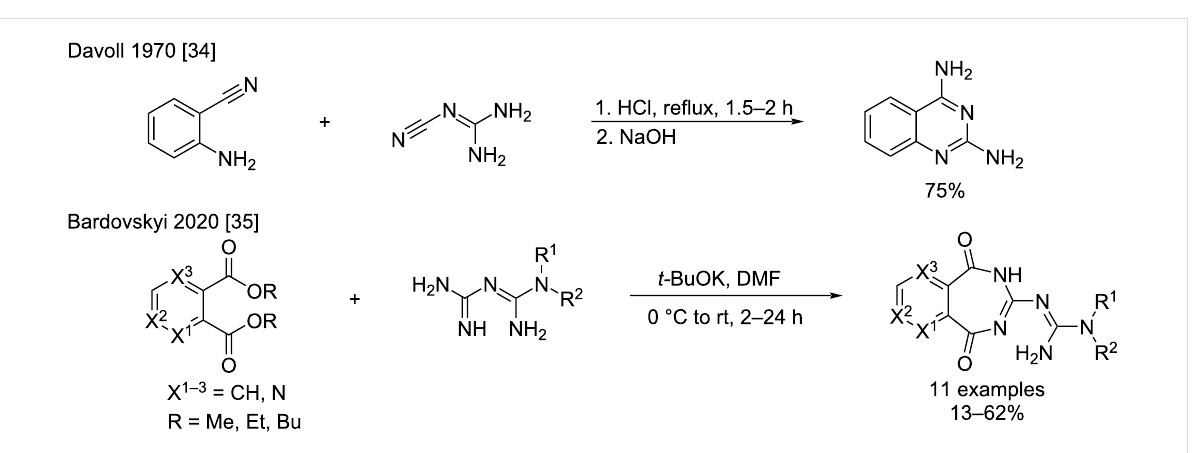
Scheme 12: Synthesis of 2,4-diaminoquinazolines by the addition of 2-cyanoaniline to cyanoguanidine and from 3-guanidinoarylo[ e ][1,3]diazepine- 1,5-dione derivatives by double ester condensations